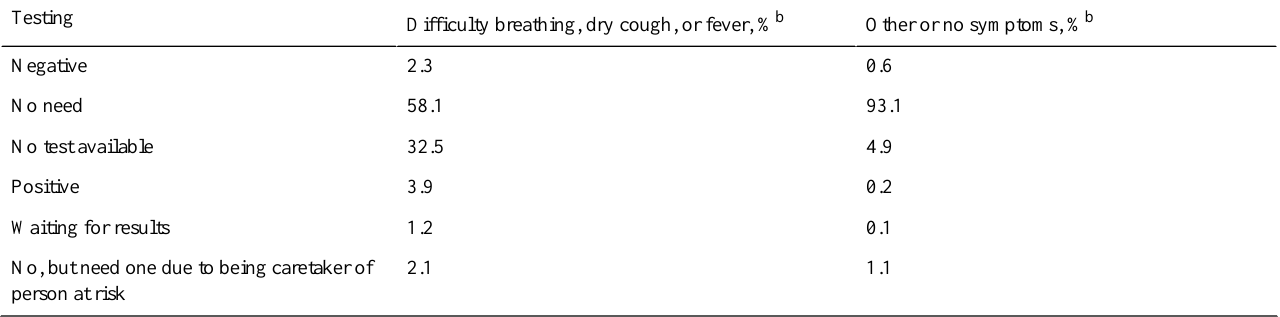
Table 3. Testing needs, depending on the presence of symptoms.